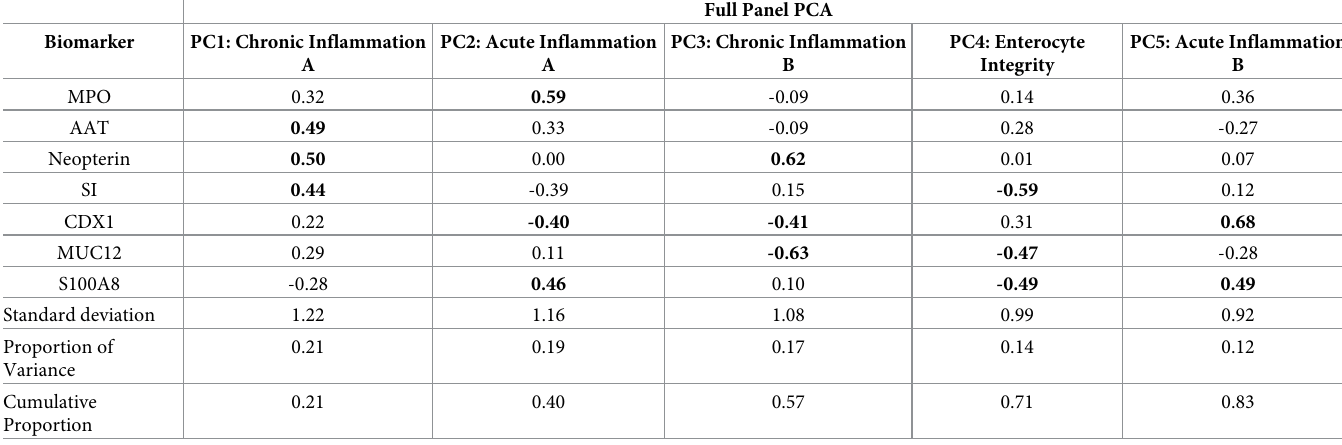
Table 4. Factor loading values and the derivation of PCA score models. Factor loading values of > 0.4 or < -0.4 are